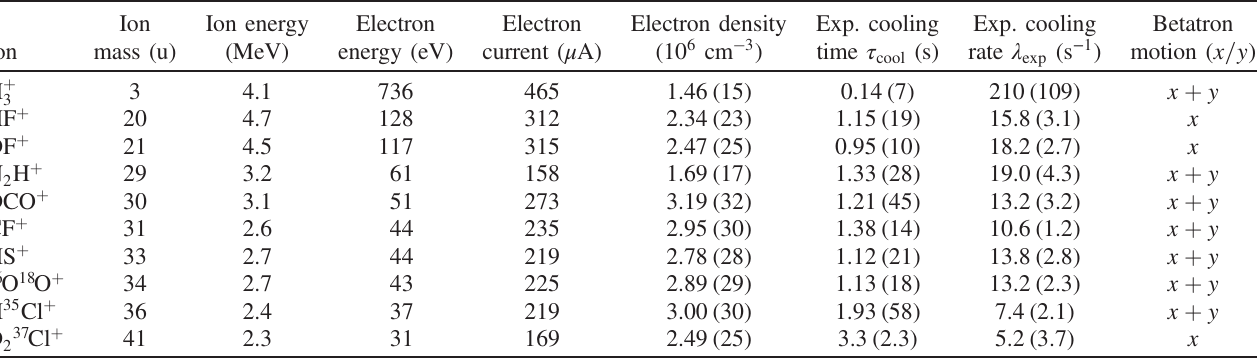
TABLE I. Operating parameters of the Electron Target, measured transverse cooling times τ rates λ deduced from Eq. (19) for different molecular ions in the TSR. In all experiments, the photocathode operated at an estimated exp temperature of ≃ 200 K, and the beam was magnetically expanded by a factor α ¼ 20 [Eq. (13)]. The column “ betatron motion ” indicates whether the horizontal ( x ) or vertical ( y ) betatron damping of the ion beam was evaluated. A label “ x þ y ” indicates that the cooling times for horizontal and vertical motions matched within their uncertainties, and that the given numbers are the average of